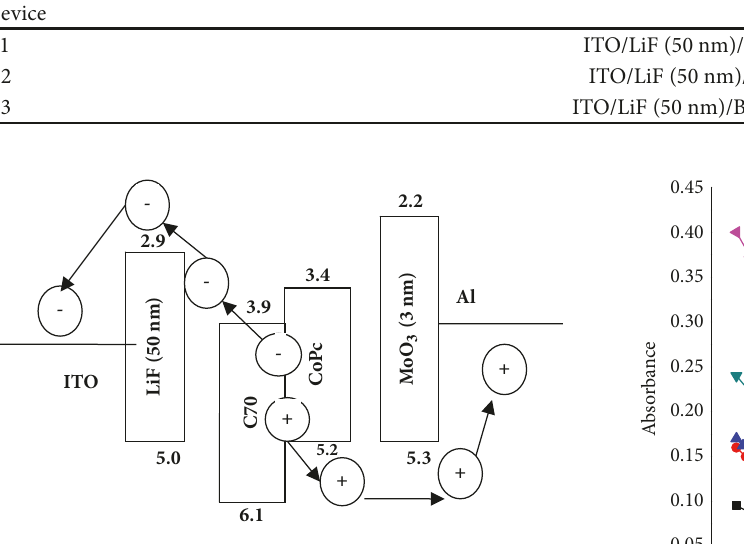
Figure 4: Operating process of device C.